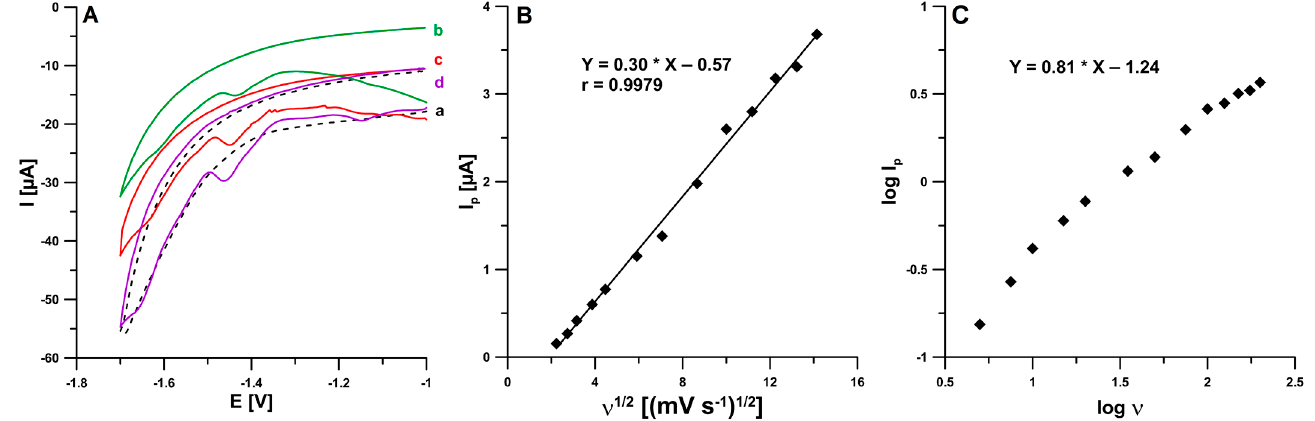
Figure 4. ( A ) CV curves obtained at the pSPCE/PbNPs in the 0.05 M NaAc—HAc buffer (pH 4.5) containing 0.05 mmol L − 1 Pb(II) and 0 M BLM (dashed line, a) or 0.1 µM BLM (solid line, b, c, and d) ( υ = 50, 100 and 200 mV/s). ( B ) The dependence between the BLM peak current (I p ) and the square root of the scan rate ( υ 1/2 ) ( υ in the range of 5–200 mV/s). ( C ) The dependence between the log of the BLM peak current (log I p ) and the log of the scan rate (log υ ) ( υ in the range of 5–200 mV/s).